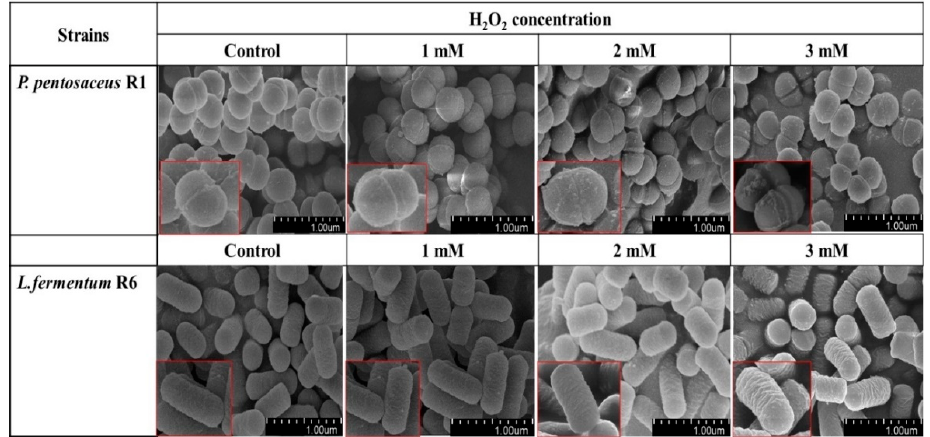
Figure 2. Scanning electron micrographs of Pediococcus pentosaceus R1 and Lactobacillus fermentum R6 incubated in MRS broth with different H 2 O 2 concentrations for 1 h.